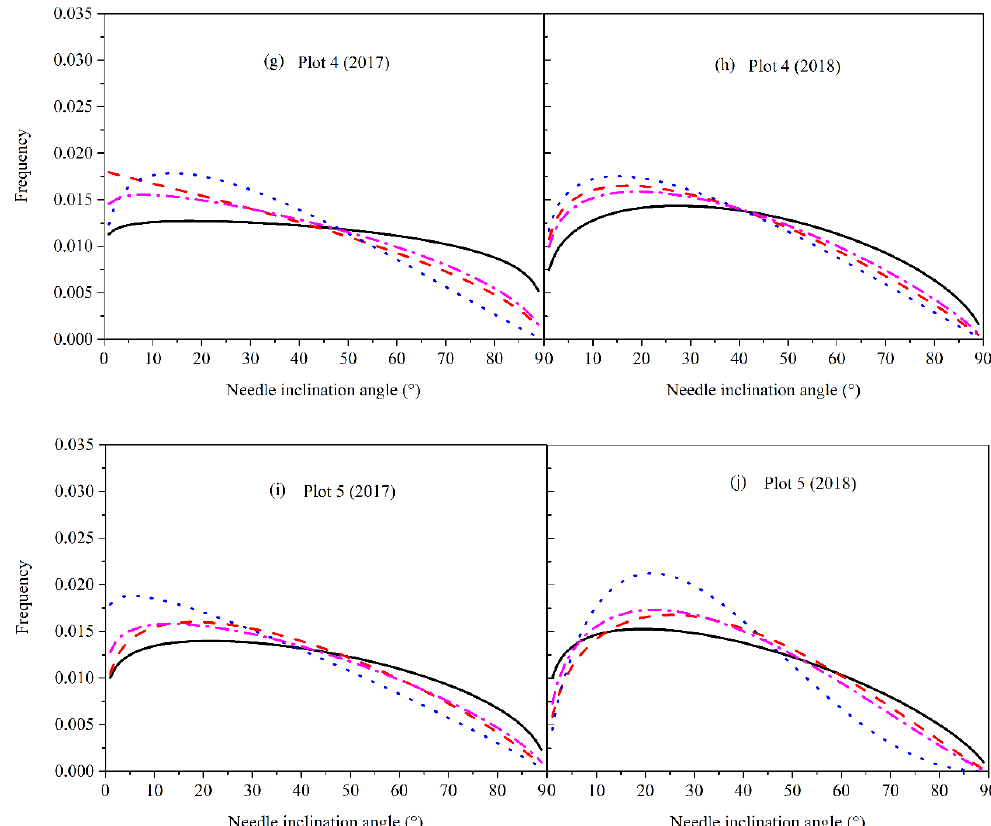
Figure 7. Vertical and annual variations in needle inclination angle distributions in the five plots in 2017 and